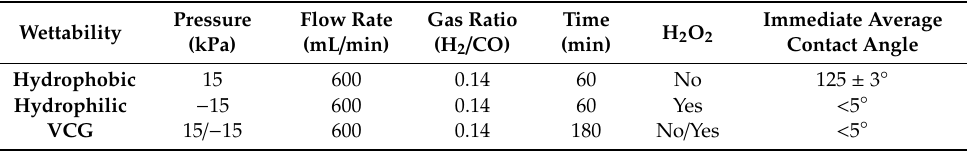
Table 2. Photo-initiated chemical vapor deposition (PICVD) process conditions to grow hydrophobic, hydrophilic, and vertical chemical gradient (VCG) coatings.